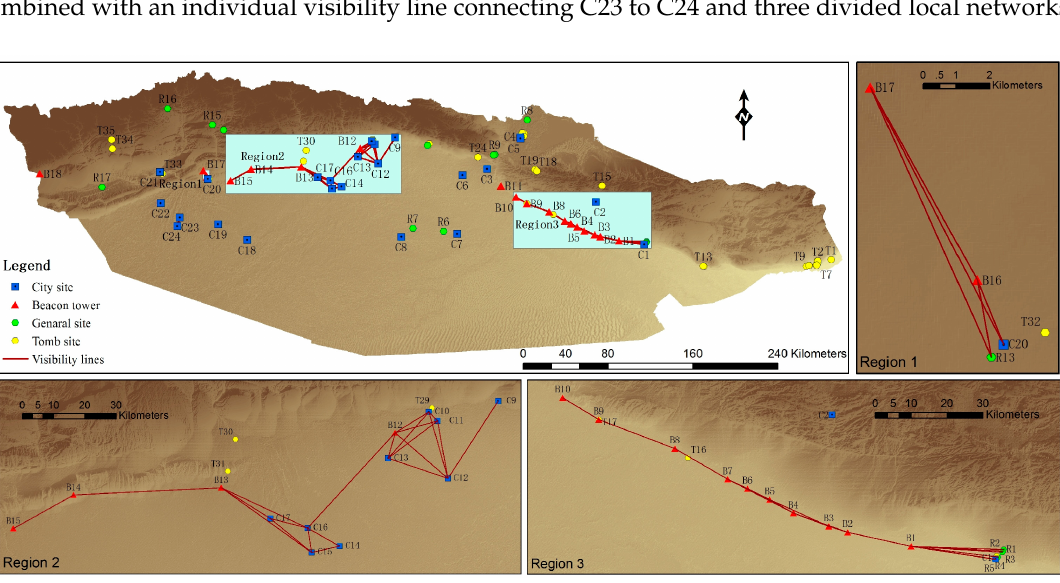
Figure 2. Visibility network for military defense in the Han Dynasty. It is combined with lines of sight and defense related sites, including city sites, beacon towers and general sites.